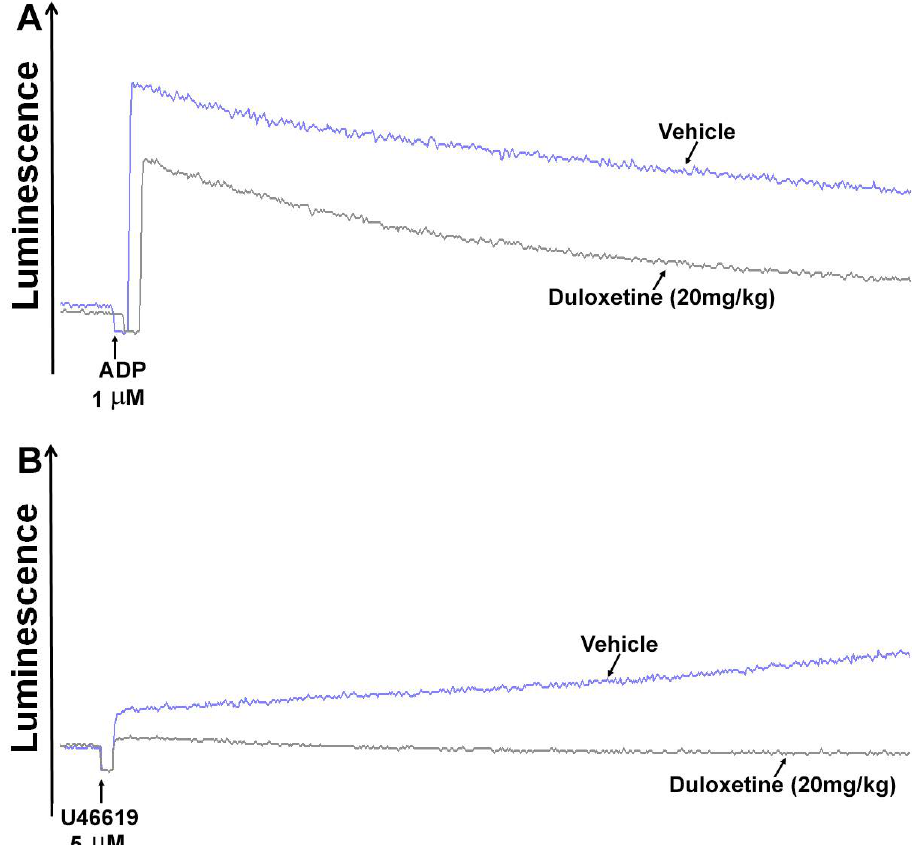
Figure 3. Duloxetine inhibits dense granule secretion ex vivo. Mice were injected with 20 mg/kg of duloxetine one hour prior to platelet collection. Platelets were incubated with 12.5 μ L of luciferase luciferin before stimulation with either ADP (1 μ M; ( A )) or U46619 (5 μ M; ( B )) for 5 min. ATP dense granules release (luminescence) was measured using an aggregometer. These experiments were re- peated three times, using blood pooled from six-eight mice each time.